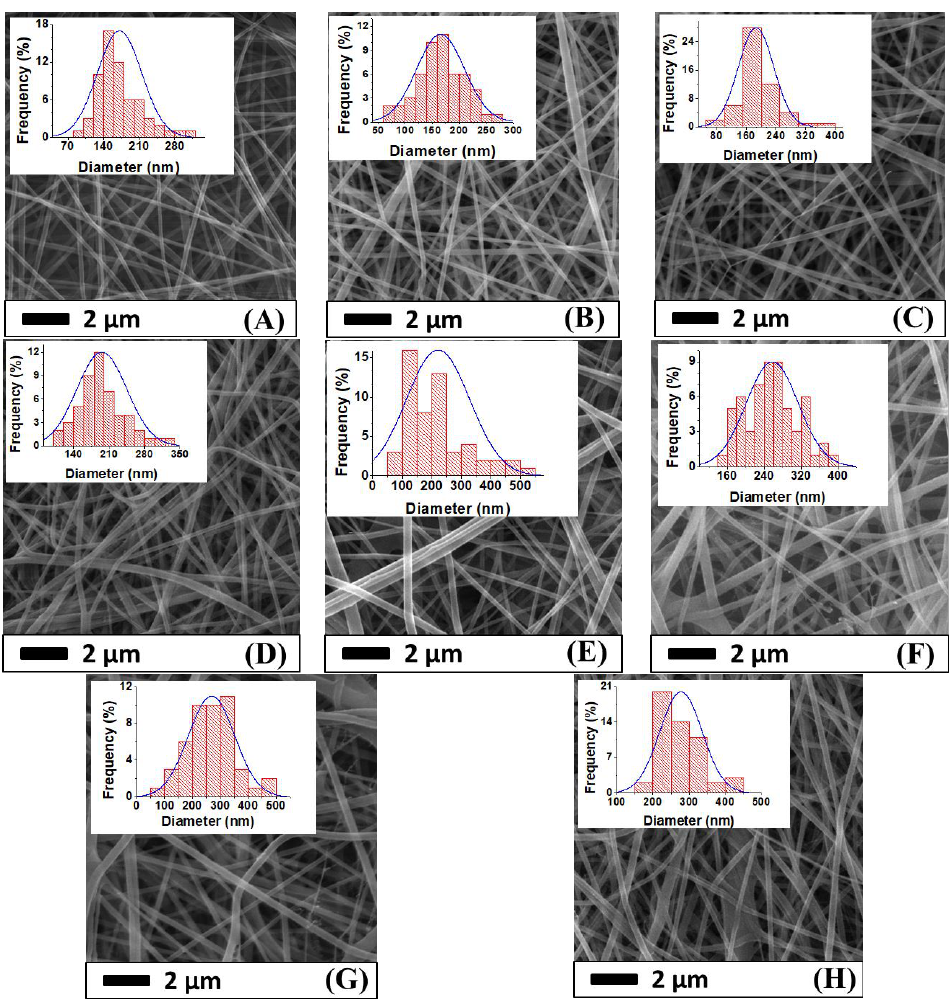
Figure 7. SEM images and fiber diameter distribution of ( A ) PAN nanofiber web before lamination; ( B ) PAN50; ( C ) PAN75; ( D ) PAN100; ( E ) PVDF nanofiber web before lamination; ( F ) PVDF50; ( G ) PVDF75; and ( H ) PVDF100.